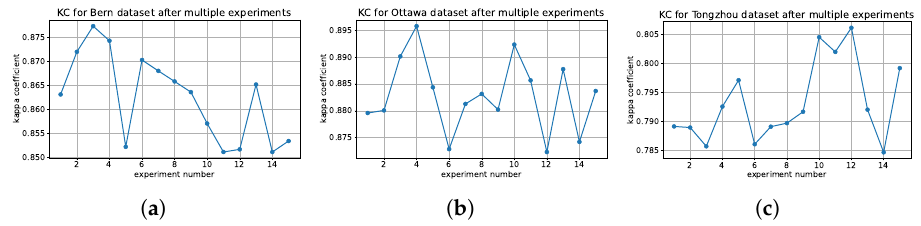
Figure 20. The effect of random initialization on three datasets. ( a ) Bern dataset. ( b ) Ottawa dataset. ( c ) Tongzhou dataset.